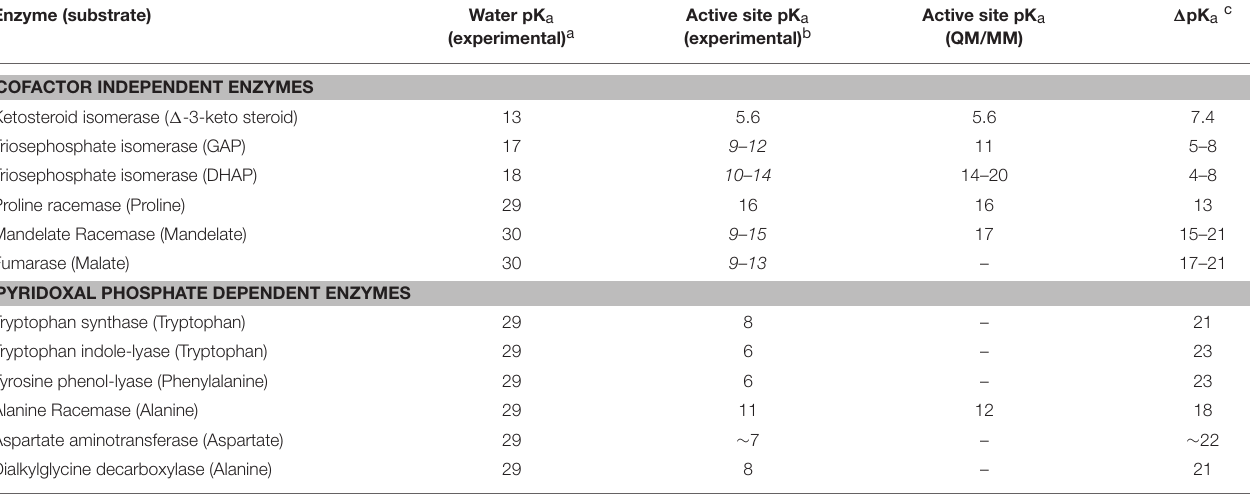
TABLE 1 | Carbon Acid (Substrate C-H) pK a values. Enzyme (substrate)